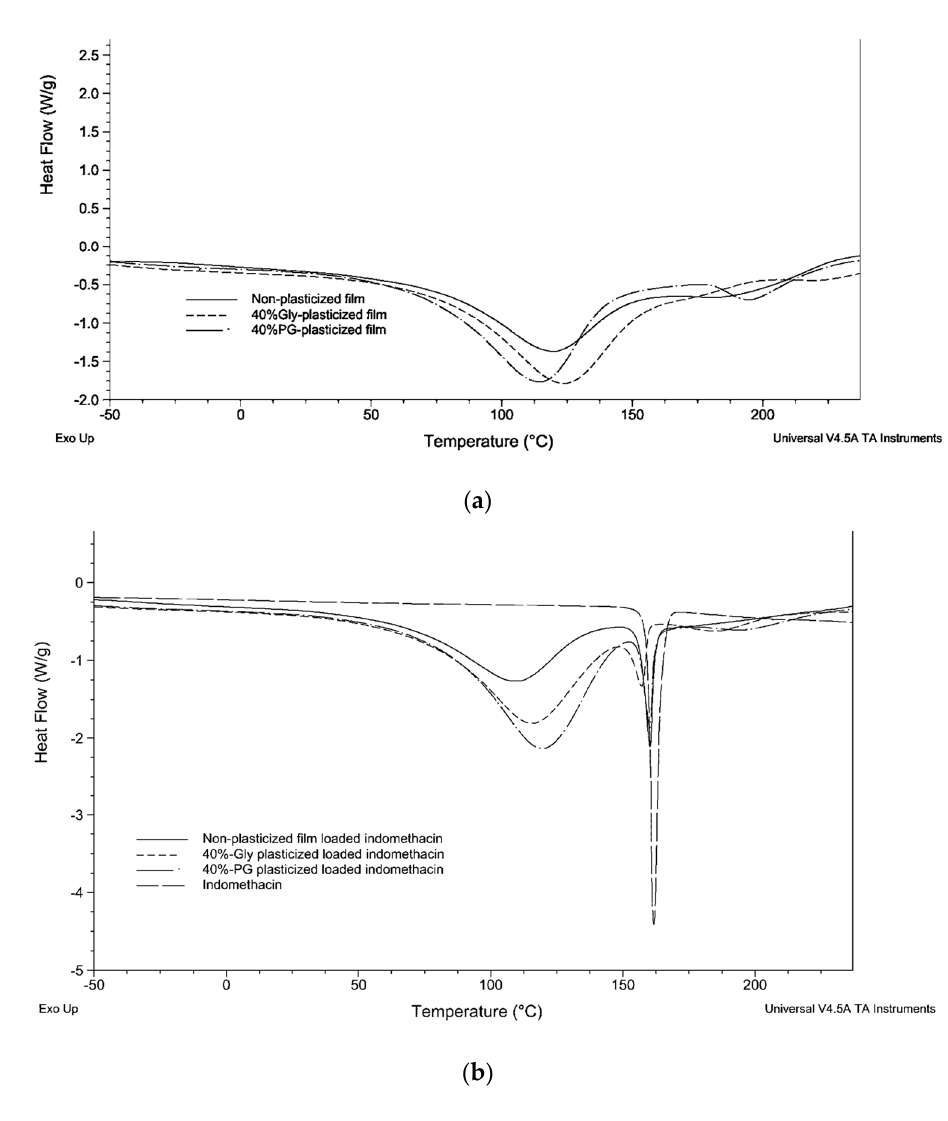
Figure 3. Differential scanning calorimetry (DSC) curves of pectin films with and without plasticizer ( a ) and with indomethacin ( b ). Table 2. Endothermic peak temperatures (EPT) and change in enthalpy in the endothermic process ( Δ H ) of non-plasticized, 40% Gly-plasticized and 40% PG-plasticized LMP films without and with indomethacin.